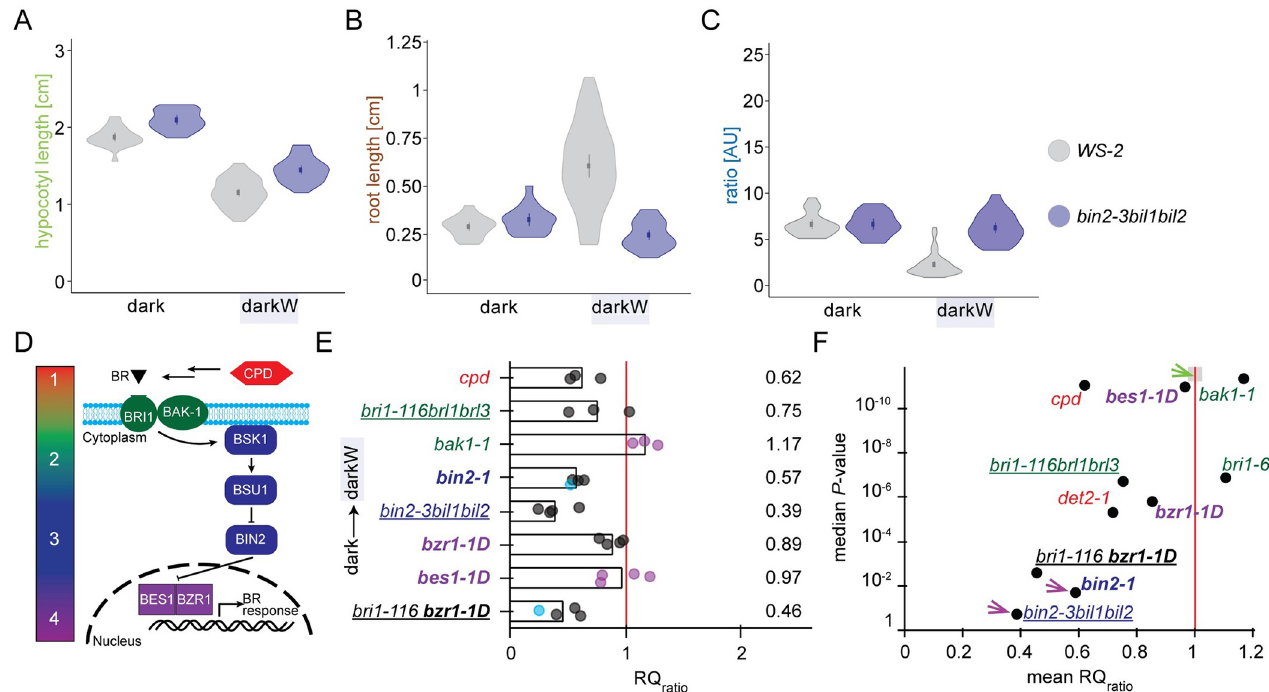
Fig 4. Responses of BR pathway mutants to water stress in the dark: violin plots, response quotients and volcano plots. (A-C) Violin plots of the hypocotyl (A), root (B) and ratio responses (C) of the triple bin2-3bil1bil2 knock out line shown in Fig 3E , with the wild-type ecotype (Ws-2) as reference. The dot represents the mean and the line the 95% confidence interval. Note the high variance of the wild-type root response under darkW. bin2-3bil1bil2 mutants qualified as decision mutants on 3 counts: (i) failure to adjust the hypocotyl/root ratio to darkW (the ratio for darkW is the same as for dark in panel C), (ii) low or non-significant P-value (see panel f below) and (iii) one organ (here the hypocotyl in panel a) exceeded wild-type length under darkW. (D) Color coding of steps in the BR signalling pathway; 1: biosynthesis, 2: perception, 3: signalling, 4: transcription. See text for further detail. (E) RQ ratio response quotient of the hypocotyl/root ratios under dark/darkW conditions, normalized to the wild-type ratio quotient; a value of 1 (vertical red line) indicates that the response to a shift from dark to darkW is similar to that of the respective wild-type ecotype. Each replicate is represented by a dot; purple dots are for initial and grey dots for optimized screen conditions; blue dots are for data from SEM measurements. Note that the triple bin2bil1bil2 knock out has the strongest phenotype, followed by bri1-116 bzr1-1D and bin2-1 . (F) Volcano plot with the mean RQ ratio depicted in (E) on the X -axis and the median P -Value of the response on the Y -axis (negative log scale; a median of all replicates was used). Mutants in the lower left quadrant are considered to have a “confused decision phenotype” (see text). Only bin2 alleles (magenta arrows) or bypass mutants map to this quadrant. The area shaded in grey on the red line (green arrow) is where wild-type ecotypes would theoretically map onto the plot. Mutant alleles and their ecotypes are described in S1 Table . Null alleles are depicted in regular font, semi-dominant or dominant in bold and higher order mutants are underlined. See related S6, S7, S8, S9, S10 and S11 Figs